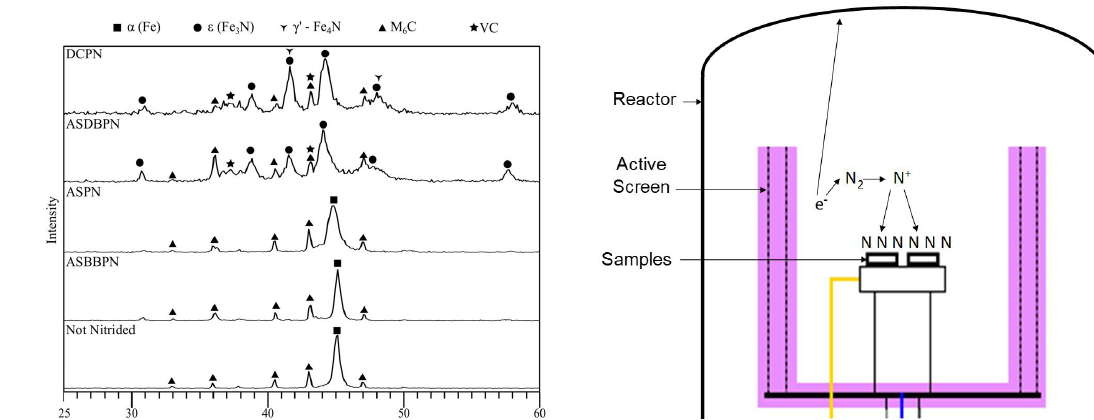
Figure 6. Microhardness profiles for the nitrided specimens.